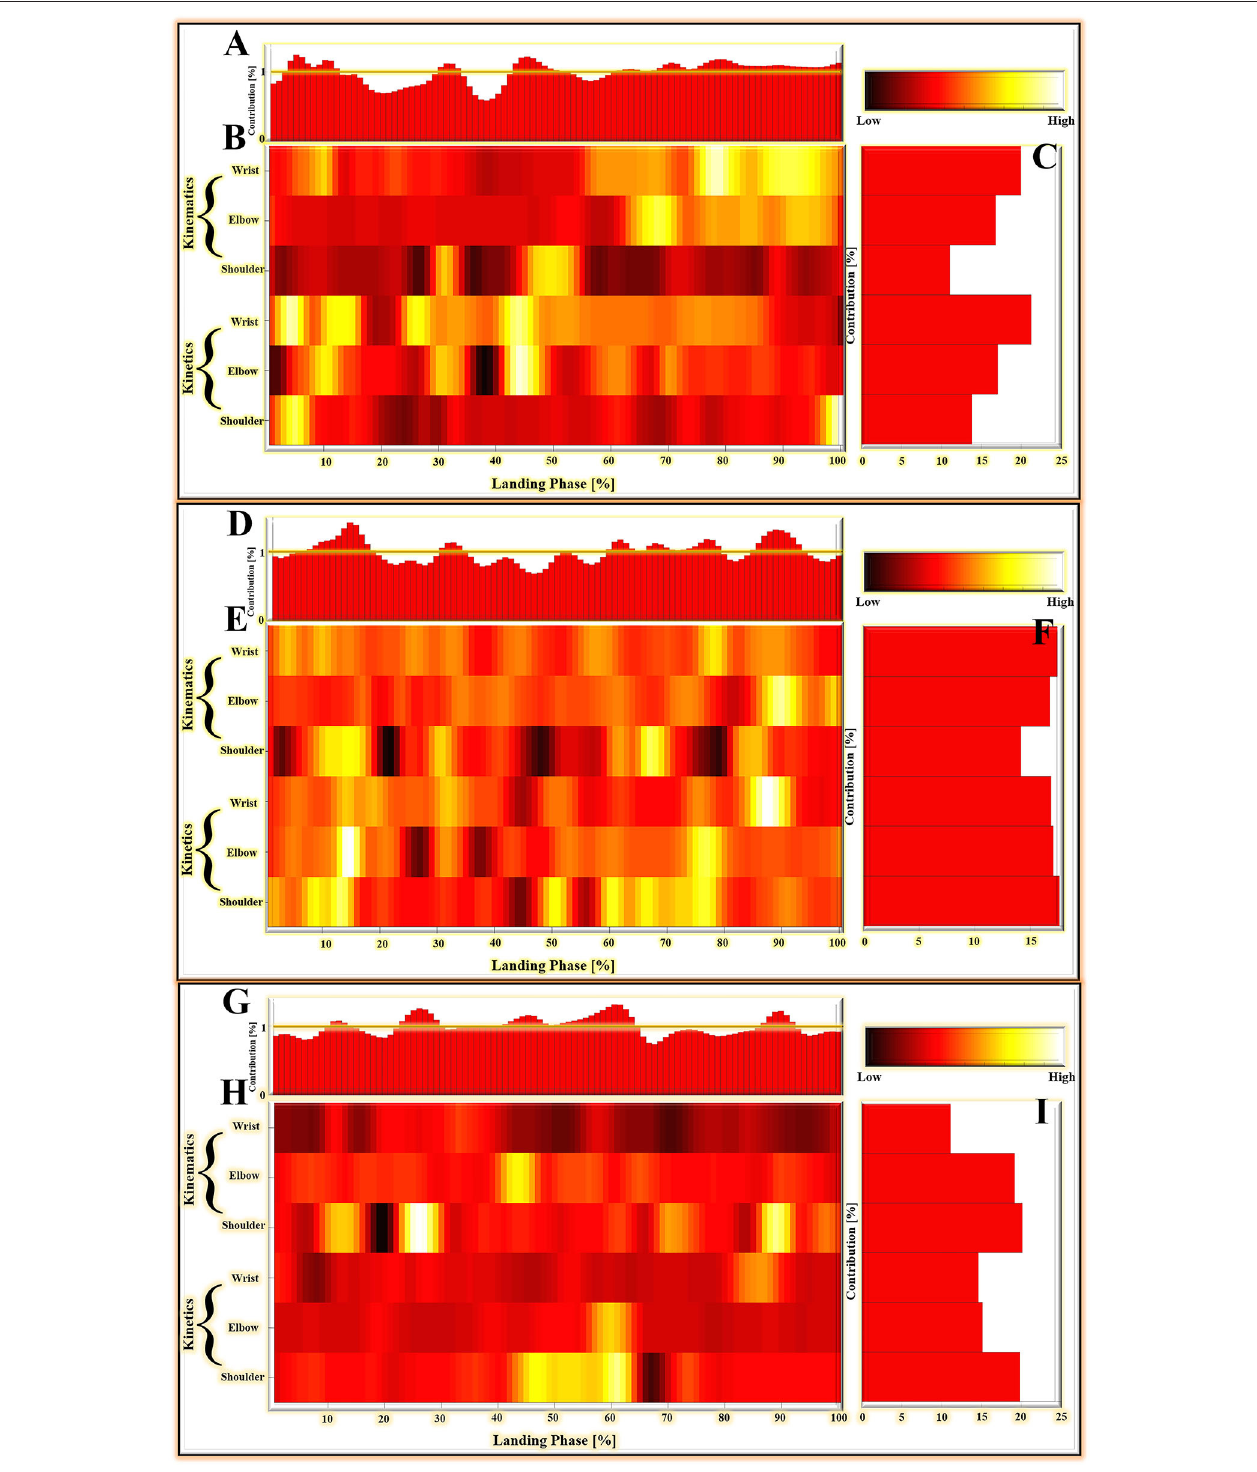
FIGURE 7 | (A–C) The LPR results in the average absolute relevance score of every variable in the landing pattern based on matrices M 1 . (D–F) The LPR results in the average absolute relevance score of every variable in the landing pattern based on matrices M 2 . (G–I) The LPR results in the average absolute relevance score of every variable in the landing pattern based on matrices M 3 . (A,D,G) The relative contribution of variables during the overall landing phase (1–100%). (B,E,H) The detailed distribution of relevance score during each joint (wrist, elbow, and shoulder) of kinematics (joint angle) and kinetics (joint moment). The lighter colors